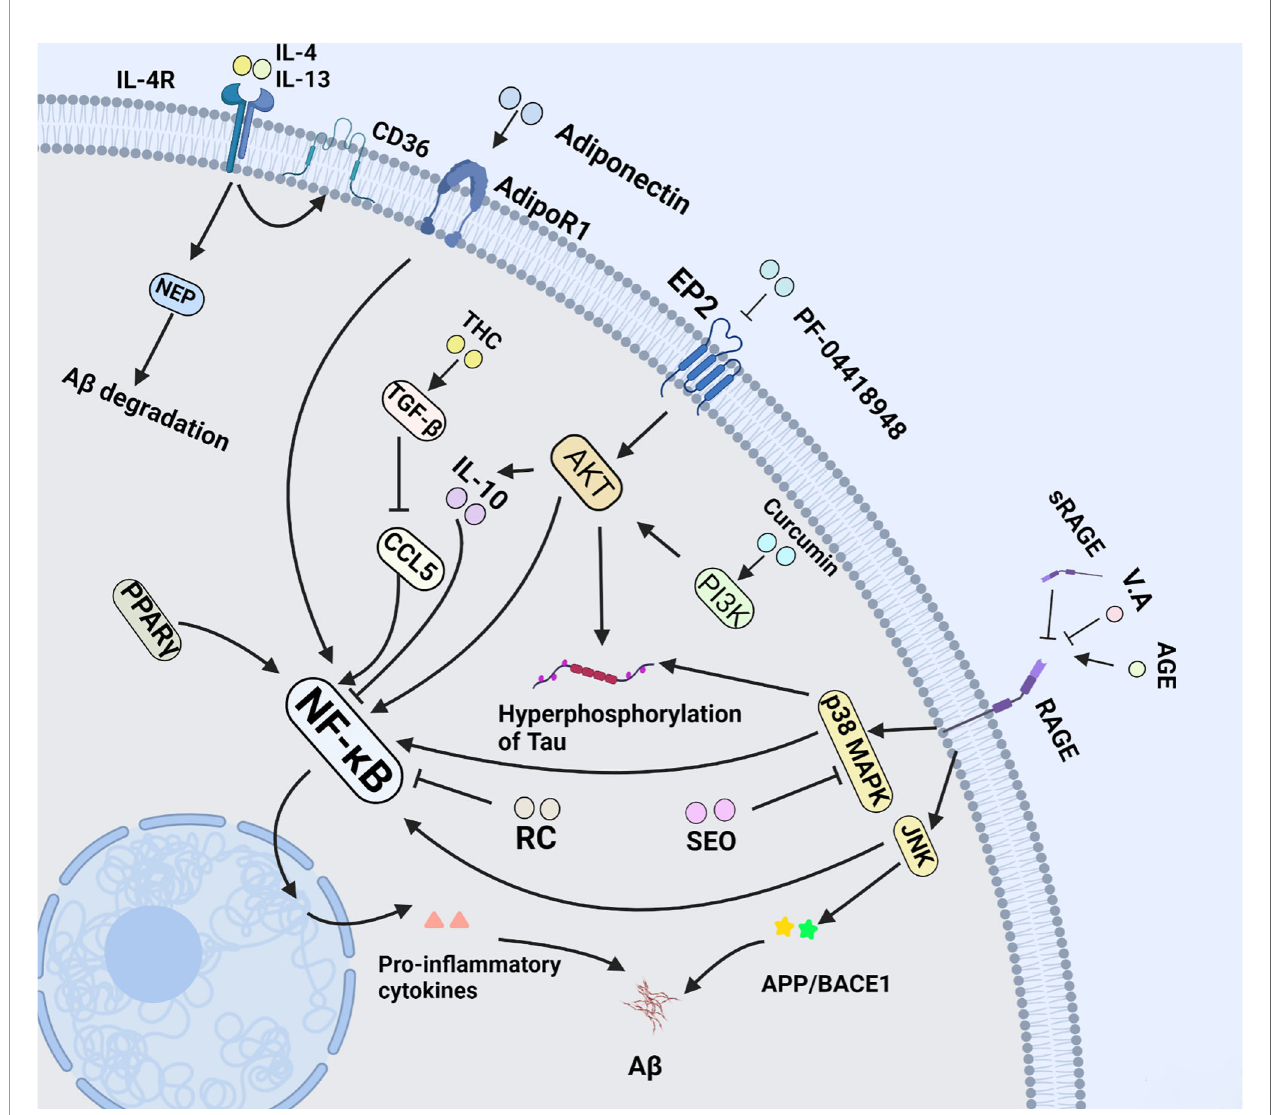
FIGURE 3 | NF- k B pathway in microglia of AD. NF- k B signal pathway plays a central role in microglia-mediated neuroin fl ammation. This fi gure introduces multiple drugs mentioned in this review above, and their effects on microglia at length via NF- k B signal